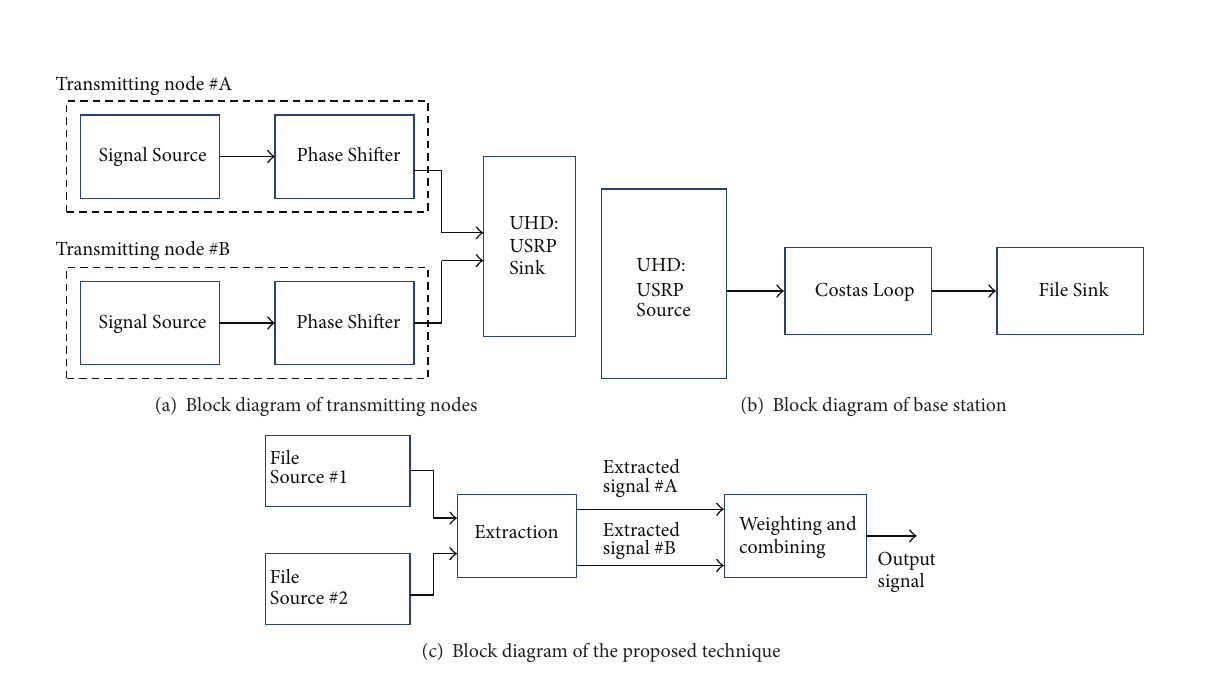
Figure 12: The programming block diagram for experiment on received signal